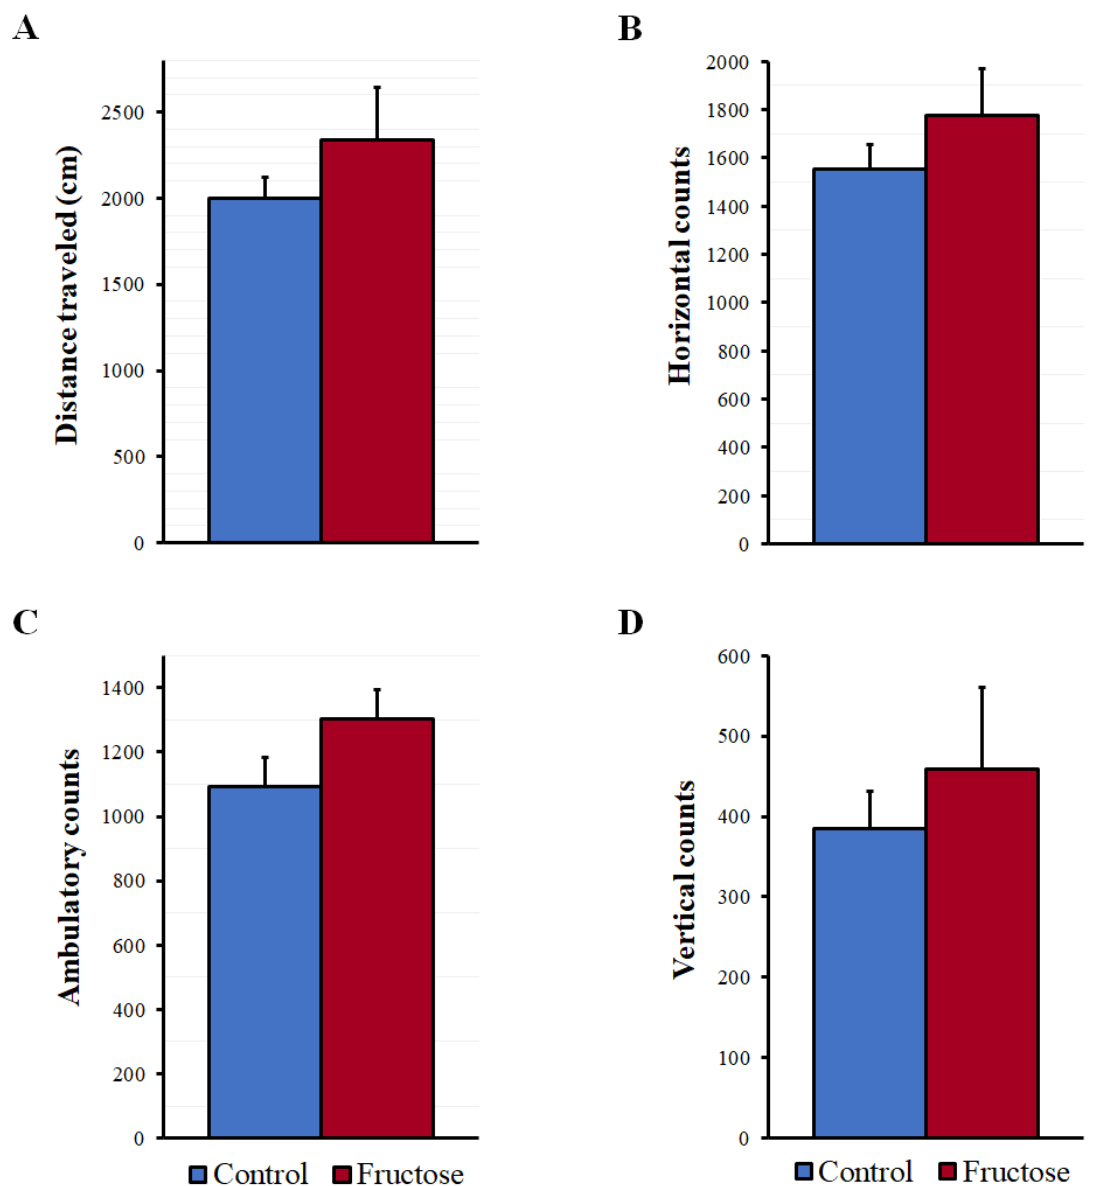
Figure 3. Parameters of spontaneous locomotor activity after the 10% fructose ingestion for five weeks. ( A ) Total distance traveled (cm), ( B ) horizontal activity (arbitrary units), ( C ) ambulatory activity (arbitrary units) and ( D ) vertical activity (arbitrary units) were monitored over 10 min periods. Results are expressed as mean ± SEM, N = 5–6 per group. The differences between the groups were analyzed with a t -test.